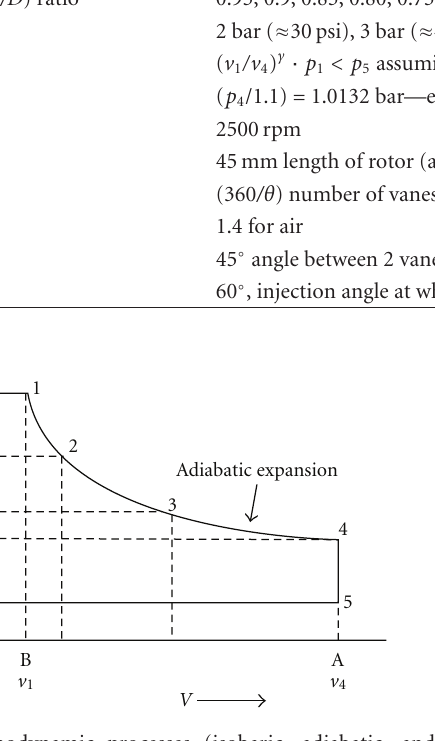
Figure 2: Thermodynamic processes (isobaric, adiabatic, and isochoric